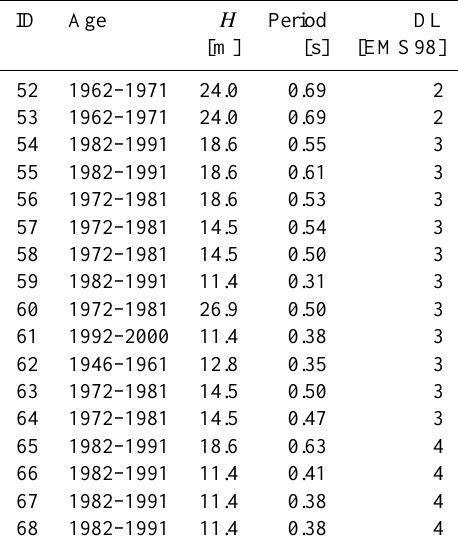
Table 2. Main characteristics of surveyed RC